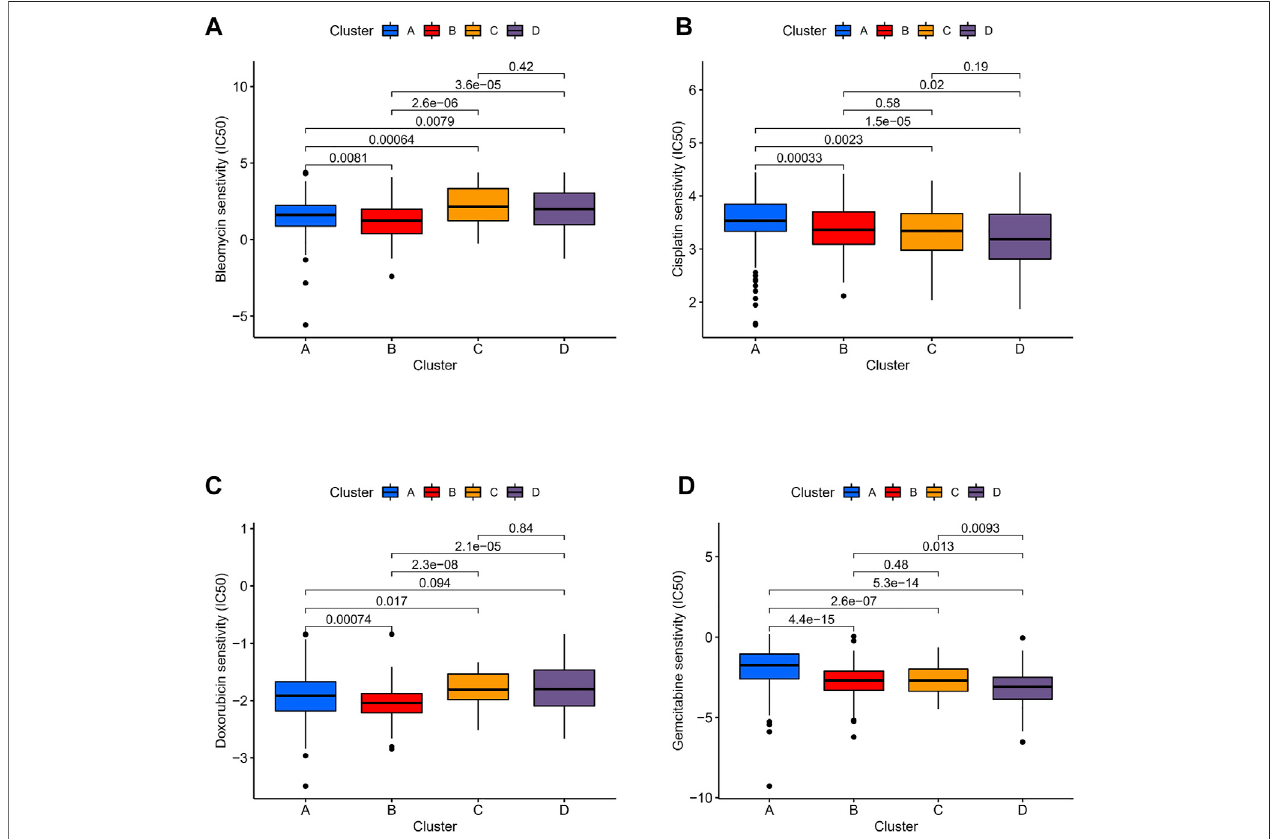
FIGURE 8 | Sensitivity of chemotherapeutics in different immune clusters. Differences in IC50 of (A) bleomycin, (B) cisplatin, (C) doxorubicin, and (D) gemcitabine were estimated among the four immune clusters.